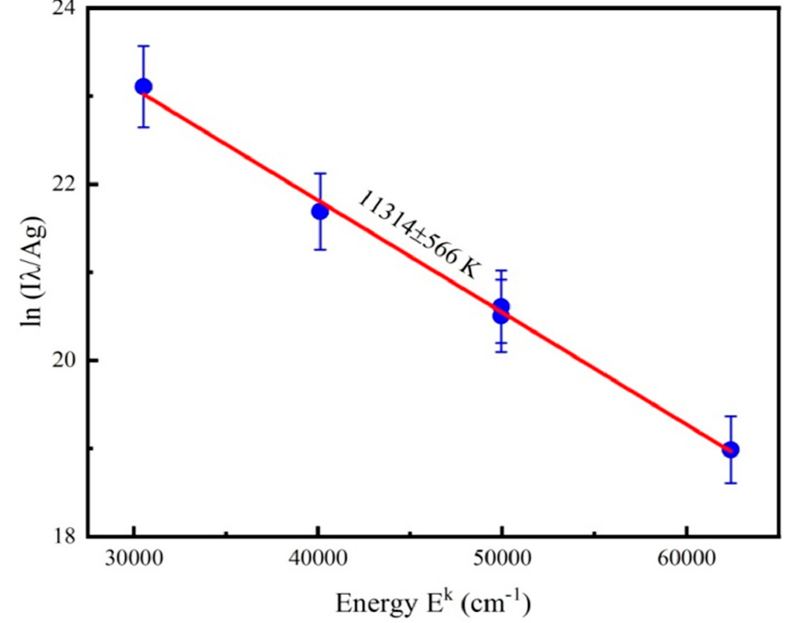
Figure 4. Boltzmann plot drawn using spectral lines of Cu-I.